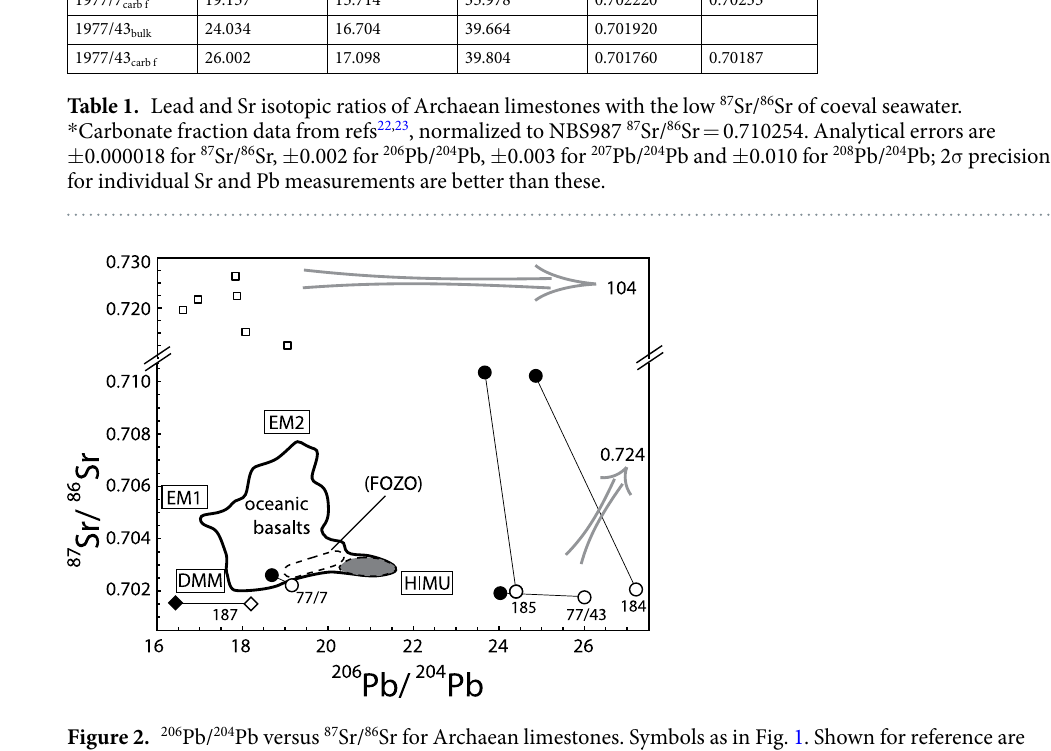
Figure 2. 206 Pb/ 204 Pb versus 87 Sr/ 86 Sr for Archaean limestones. Symbols as in Fig. 1. Shown for reference are the carbonate fractions of the few Mushandike limestones that have 87 Sr/ 86 Sr data (gray arrows point to the approximate location of other samples), the field for oceanic basalts and locations of proposed mantle end- components.